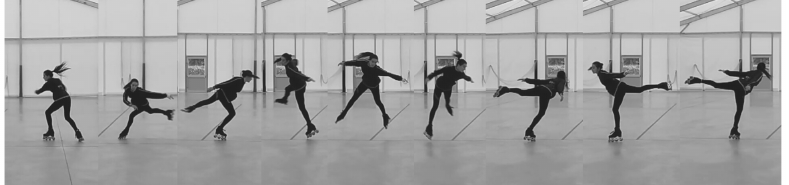
Figure 7. Flying camel spin. Max height detected: 23.6 cm. The element was discarded by the algorithm as it detected a fast spin after